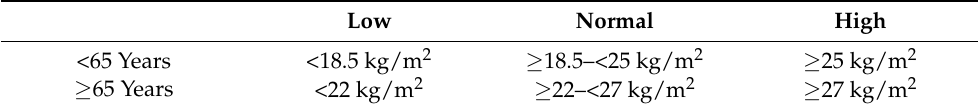
Table 1. Body mass index (BMI) classification according to